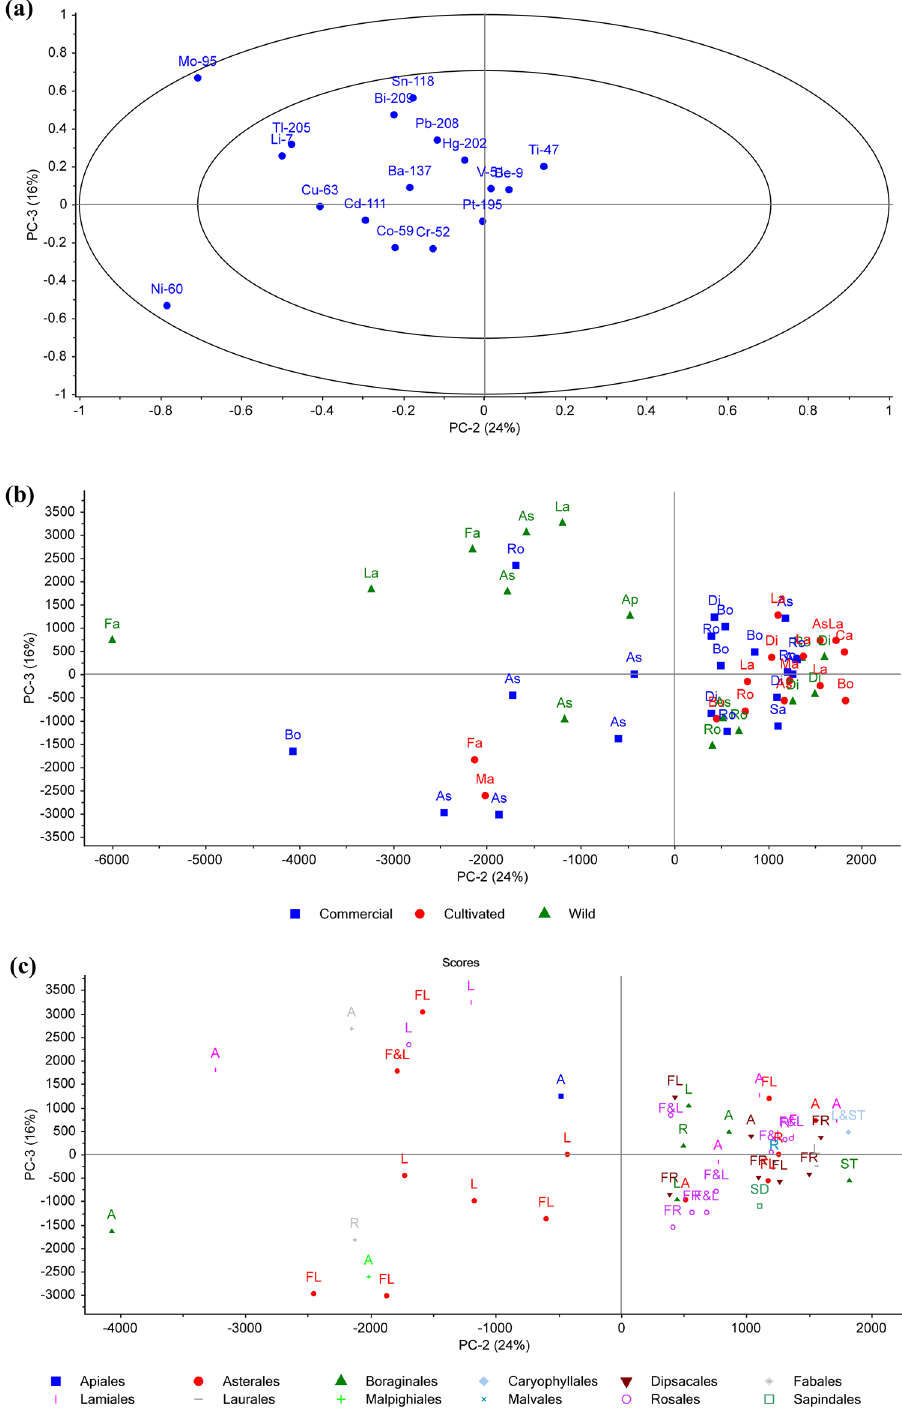
Figure 3. PCA (PC2vPC3) correlation loadings ( a ) and score plots grouped by ( b ) type and labelled by taxonomic order, and ( c ) grouped by taxonomic order and labelled by plant part. Taxonomic orders and plant part abbreviated as per Table